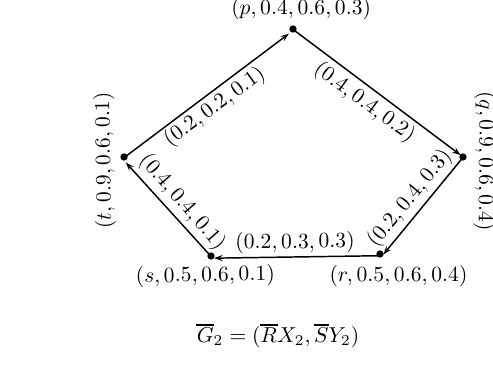
Figure 4: Neutrosophic Rough Digraph G = ( G